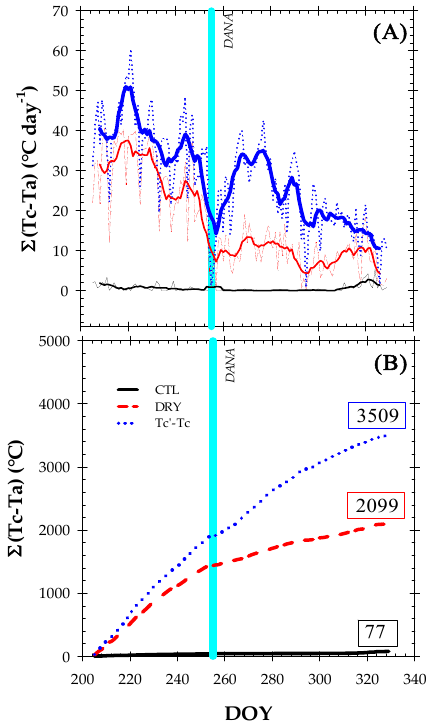
Figure (cid:561) 7. (cid:561) The (cid:561) time (cid:561) course (cid:561) of (cid:561) ( A ) (cid:561) daily (cid:561)(cid:789) Tc (cid:442) Ta (cid:561) and (cid:561) ( B ) (cid:561) integrated (cid:561) daylight (cid:561)(cid:789) Tc (cid:442) Ta (cid:561) during (cid:561) the (cid:561) exper (cid:556) Figure 7. The time course of ( A ) daily Σ Tc − Ta and ( B ) integrated daylight Σ Tc − Ta during the iment (cid:561) for (cid:561) the (cid:561) CTL (cid:561) (full (cid:442) irrigated) (cid:561) and (cid:561) DRY (cid:561) (non (cid:442) irrigated) (cid:561) treatments, (cid:561) respectively. (cid:561) In (cid:561) ( A ) (cid:561) bold (cid:561) lines (cid:561) experiment for the CTL (full-irrigated) and DRY (non-irrigated) treatments, respectively. In ( A ) bold indicate (cid:561) the (cid:561) seven (cid:442) day (cid:561) moving (cid:561) average. (cid:561) The (cid:561) solid (cid:561) vertical (cid:561) cyan (cid:561) line (cid:561) indicates (cid:561) the (cid:561) DANA (cid:561) event. (cid:561) lines indicate the seven-day moving average. The solid vertical cyan line indicates the DANA 2.4. (cid:561) Thermal (cid:561) Indexes (cid:561) vs. (cid:561) Plant (cid:561) Water (cid:561) Status (cid:561)